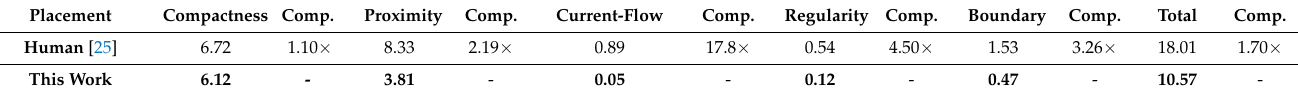
Table 3. List of topological constraints specified for the VCOTA.